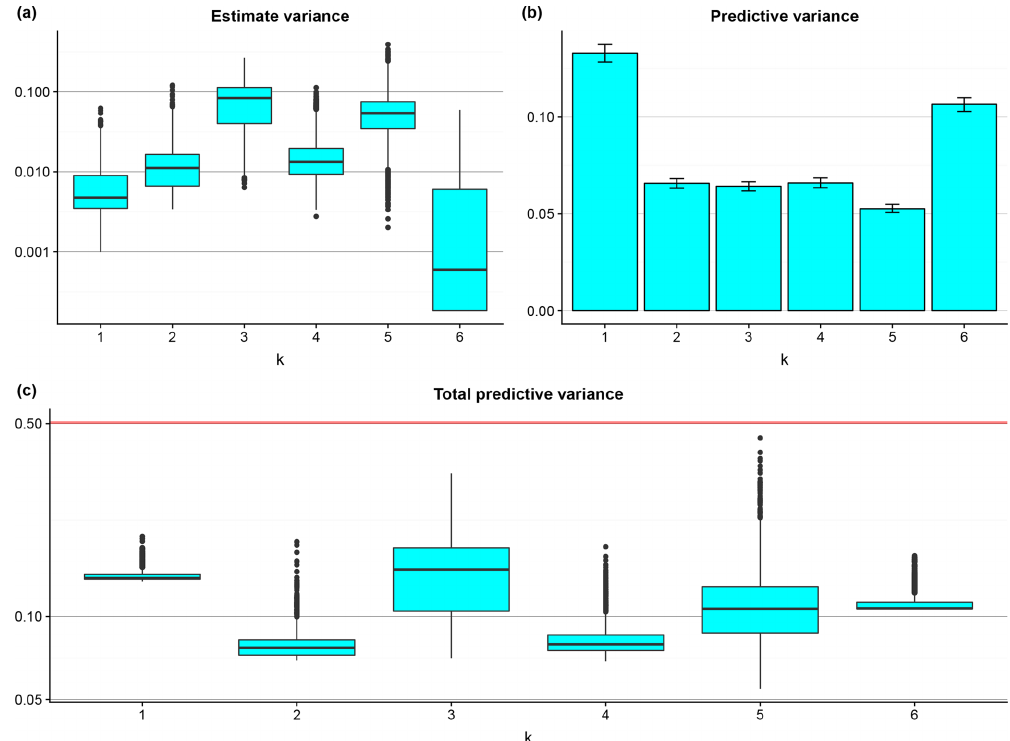
Figure 5. The box plots of the estimate variances at the testing watersheds (a) , the bar plot of the predictive variances with 95% intervals shown by the error bars (b) , and the box plots of the total predictive variances at the testing watersheds (c) . The red line indicates the variance of the benchmark model for